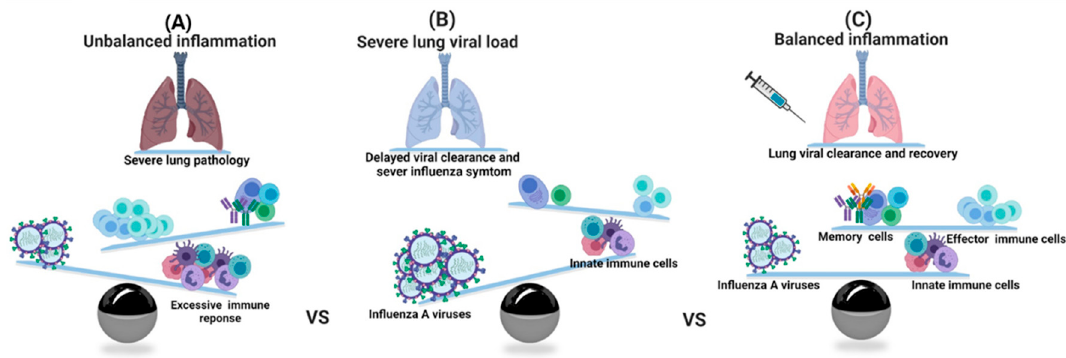
Figure 3. A schematic model showing the balance between successful viral clearance and a life-threatening immunopathology following influenza infection. ( A ) The excessive response to influenza infection results in the development of influenza immunopathology despite efficient viral clearance. The excessive inflammation sustained by an uncontrolled host response can induce epithelial disruption and lung damage. ( B ) Low immune response with immune escape from host immunosurveillance may increase viral replication, which in turn induces a strong release of secretory molecules. ( C ) The adequate cell mediated immunity with vaccination can control lung viral load without a severe lung pathology. This figure was created using the BioRender software.